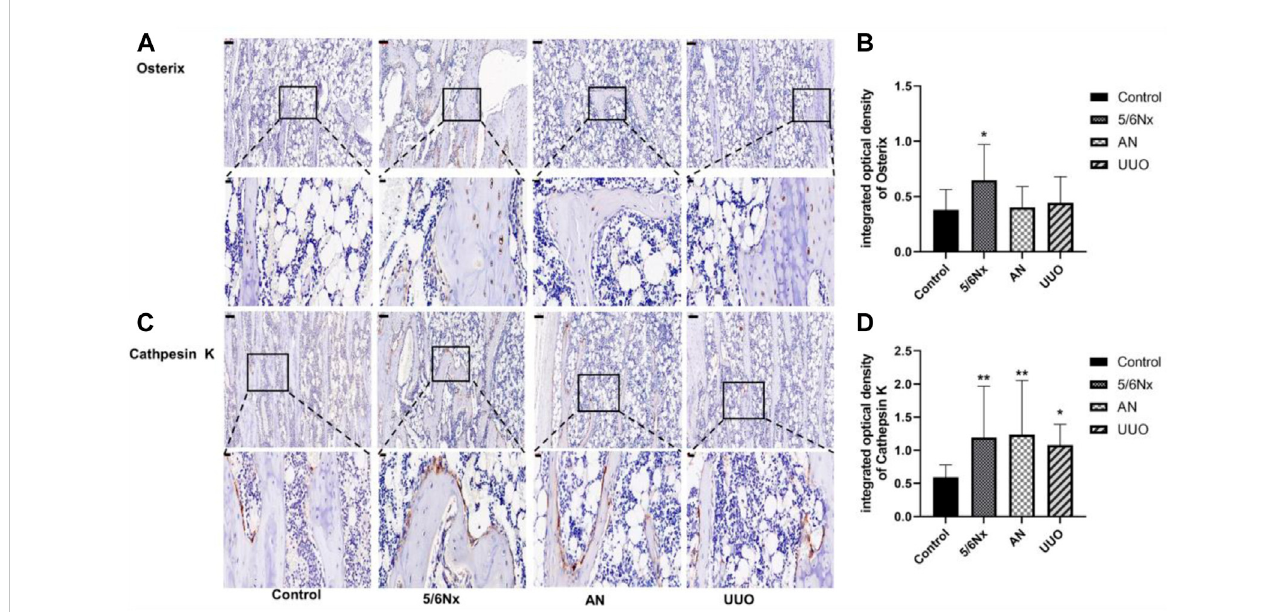
Expression of osterix and cathepsin K in the femur in the three models. (A) Protein expression of osterix in the femur; IHC staining, × 10, scale bar = 100 μ m; IHC staining, × 40, scale bar = 20 μ m. (B) Mean density of osterix staining in the femur. (C) Protein expression of cathepsin K in the femur; IHC staining, × 10, scale bar = 100 μ m; IHC staining, × 40, scale bar = 20 μ m. (D) Mean density of cathepsin K staining in the femur. Data are presented as the mean ± SD. n =